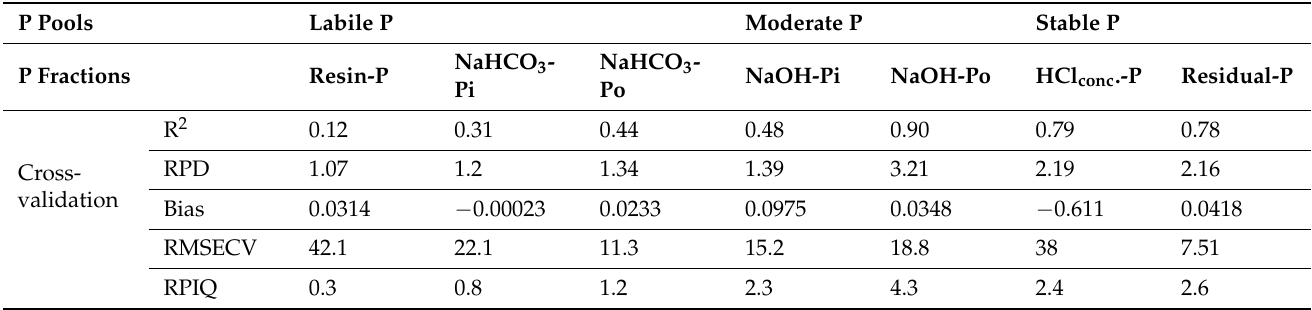
Table 5. Quality parameters for NIRS model calibration in the cross-validation process for all Hedley fractions.